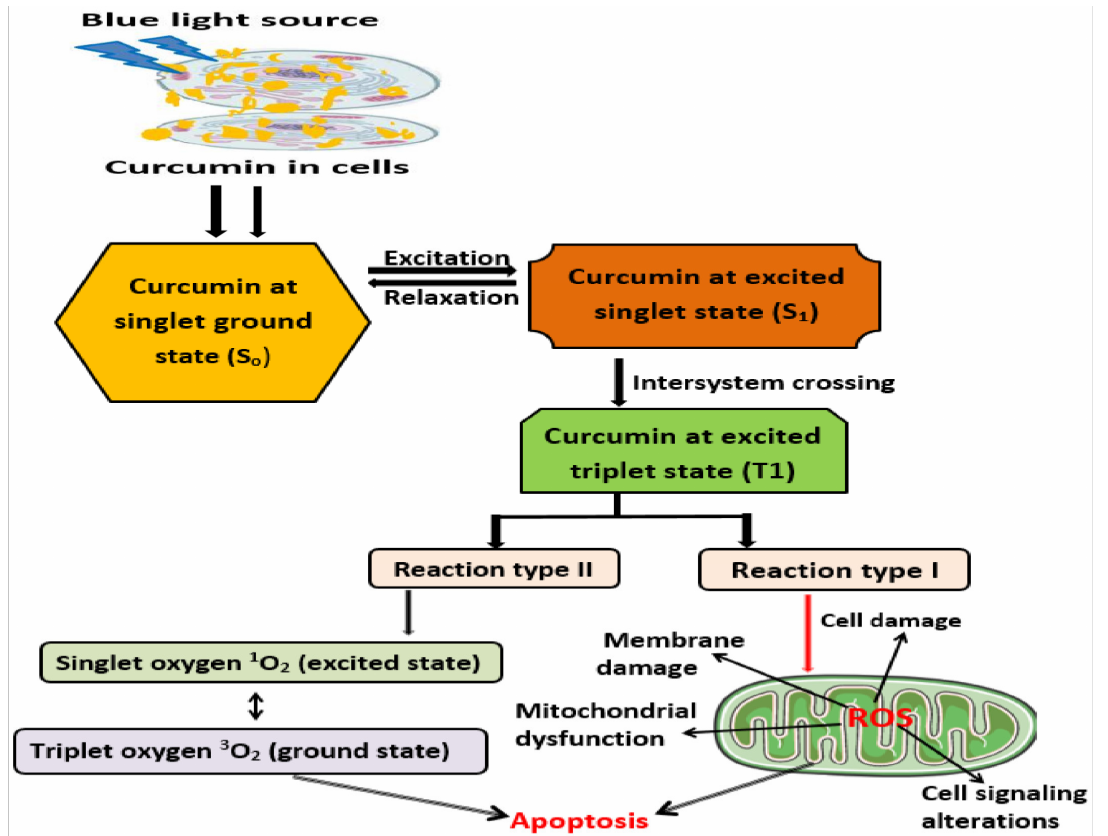
Figure 1. Absorption of specific blue-light irradiation by curcumin in cells can induce its excitation from the S 0 phase (singlet ground state) to the S 1 phase (excited singlet state). Curcumin can then enter the T 1 phase (the excited triplet state) after the intersystem crossing. Two types of reactions (type I and type II reactions) may occur at the T1 phase. Type I reactions involve reactions with biological molecules, and free radicals are formed via the transfer of electrons. ROS is generated via reactions of free radicals with oxygen. In a type II reaction, oxygen can directly react with curcumin (PS) in the excited triplet state to produce singlet oxygen. ROS production and apoptosis induction caused by curcumin photosensitization can cause various types of cell